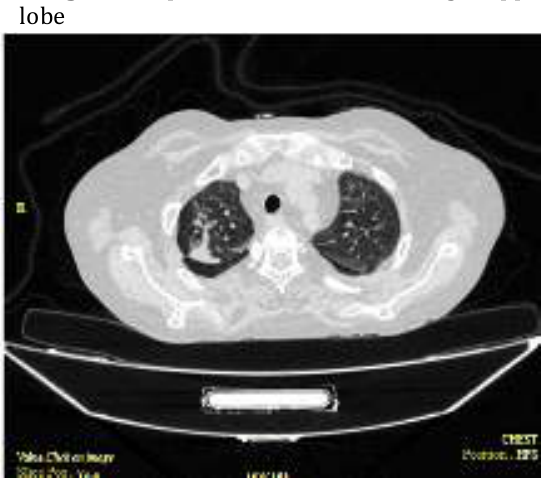
Figure 2. Lung HRCT showed multiple bilateral nodules, ground glass opacity along with mild thickening of pleura